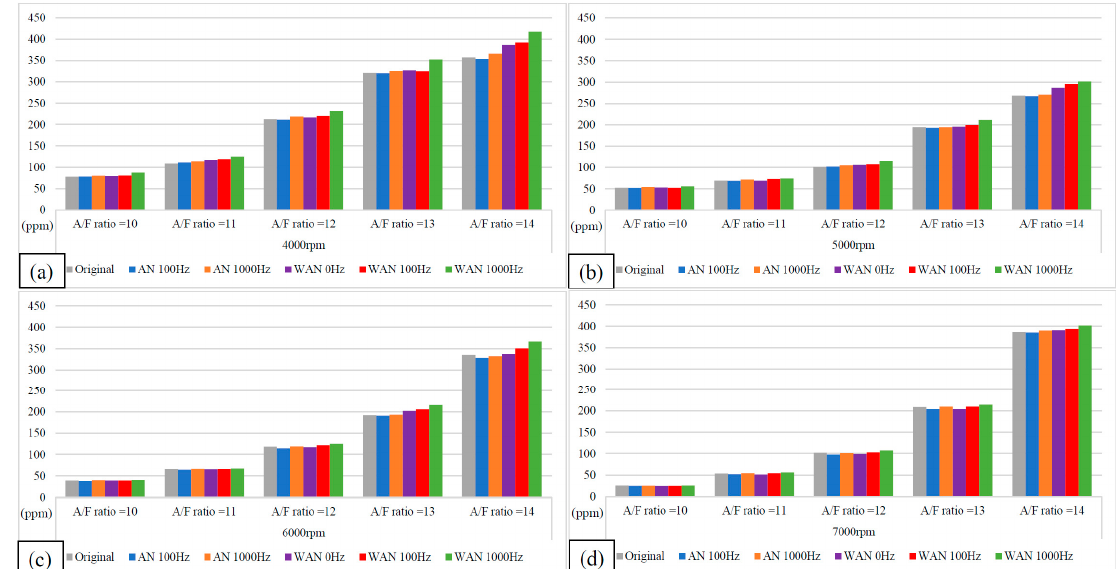
Figure 13. The NOx values and change rate of WAN and AN with different frequencies at ( a ) 4000